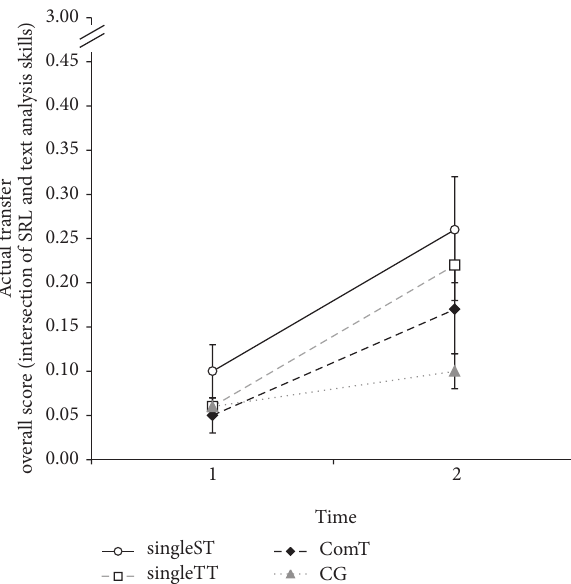
Figure 3: Depiction of the interaction ST × TT × time for the actual transfer on both SRL and text analysis skills. singleST (single student training: 𝑁 = 43 ); singleTT (singleteacher training: 𝑁 = 48 ); ComT (combined training: 𝑁 = 33 ); CG (control group: 𝑁 = 123 ). 1 = pretest, 2 =